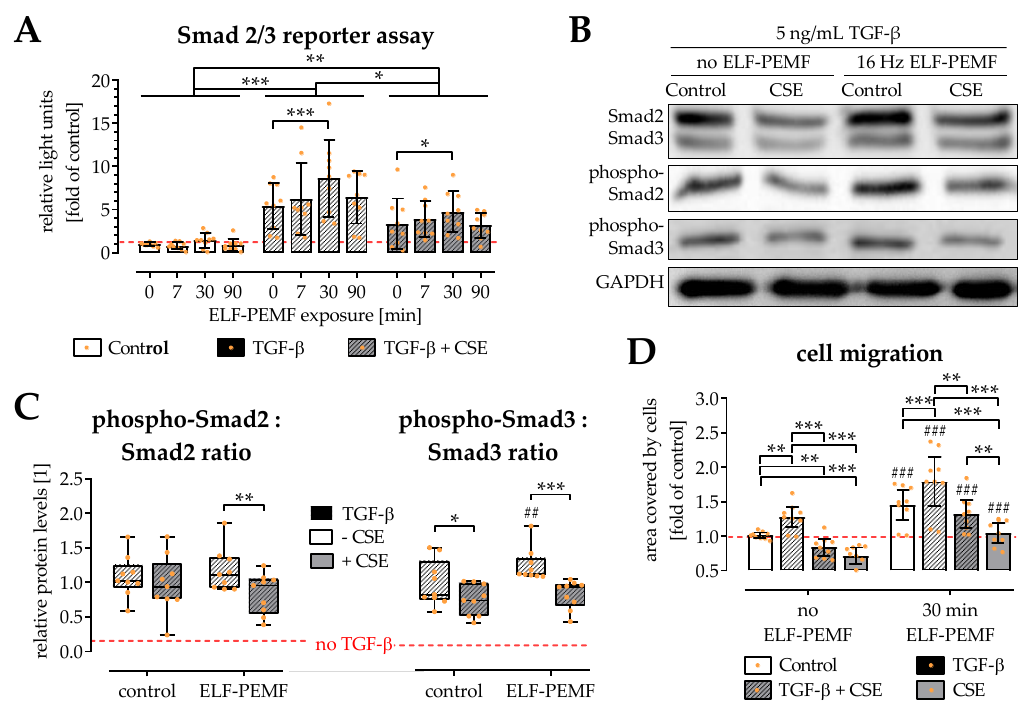
Figure 4. Canonical (Smad2/3) TGF-β signaling affected by 5% cigarette smoke extract (CSE) is fortified by exposure to the 16 Hz ELF-PEMFs. ( A ) An adenoviral reporter assay was used to quantify canonical (Smad2/3) TGF-β signaling in SCP-1 cells exposed to 5 ng/mL TGF-β, 5% CSE, and/or the 16 Hz ELF-PEMFs (0, 7, 30, 90 min daily exposure) for 72 h. Western blot was used to confirm phosphorylation of Smad2 and Smad3 in the cells with 30 min daily exposure to the 16 Hz ELF-PEMF. ( B ) Representative image of the Western blot. ( C ) Signal intensities were quantified with the ImageJ software and the ratio of phosphorylated-Smad2 to Smad2 and phosphorylated-Smad3 to Smad3 were determined. ( D ) SCP-1 cell migration was determined using the cell migration assay kit. Cells invading the migration zone were quantified using the ImageJ software. N = 3, n = 3. Data are presented as box plots (Min to Max with single data points). Data were compared by non-parametric two-way ANOVA followed by Tukey’s multiple comparison test: * p < 0.05, ** p < 0.01, and *** p < 0.001 as indicated; ## p < 0.01 and ### p < 0.001 marking the ELF-PEMF effect.